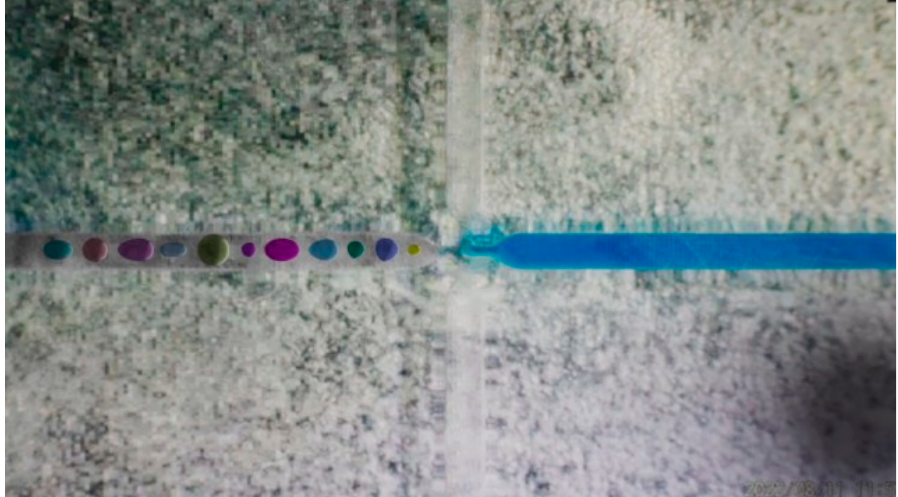
Figure 4. The image generated sample at the render stage. Parallel to it, for each such image, its black ‐ and ‐ white mask was generated. To create this image mask, material two was applied to the generated objects and a solid black tex ‐ ture was applied to the plane. The mask image data was rendered in png format with the same resolution and spatial elements arrangement. The resulting image mask sample is shown in Figure 5. Figure 5. The image mask generated sample at the render stage. The png format was used because of the alpha channel preservation considerations, i.e., producing images without compression. The image files names in the first and second cases were the same. In the next stage, an algorithm for automatic pseudodroplets labeling in synthetic data was developed and implemented. For the proposed algorithm, black ‐ and ‐ white syn ‐ thetic images masks were used. To do this, using the Pillow library, we converted the color space from the RGBA standard to HSV. After color space conversion, pixel ‐ by ‐ pixel image processing took place. The pixels were processed from top to bottom, from left to right. In